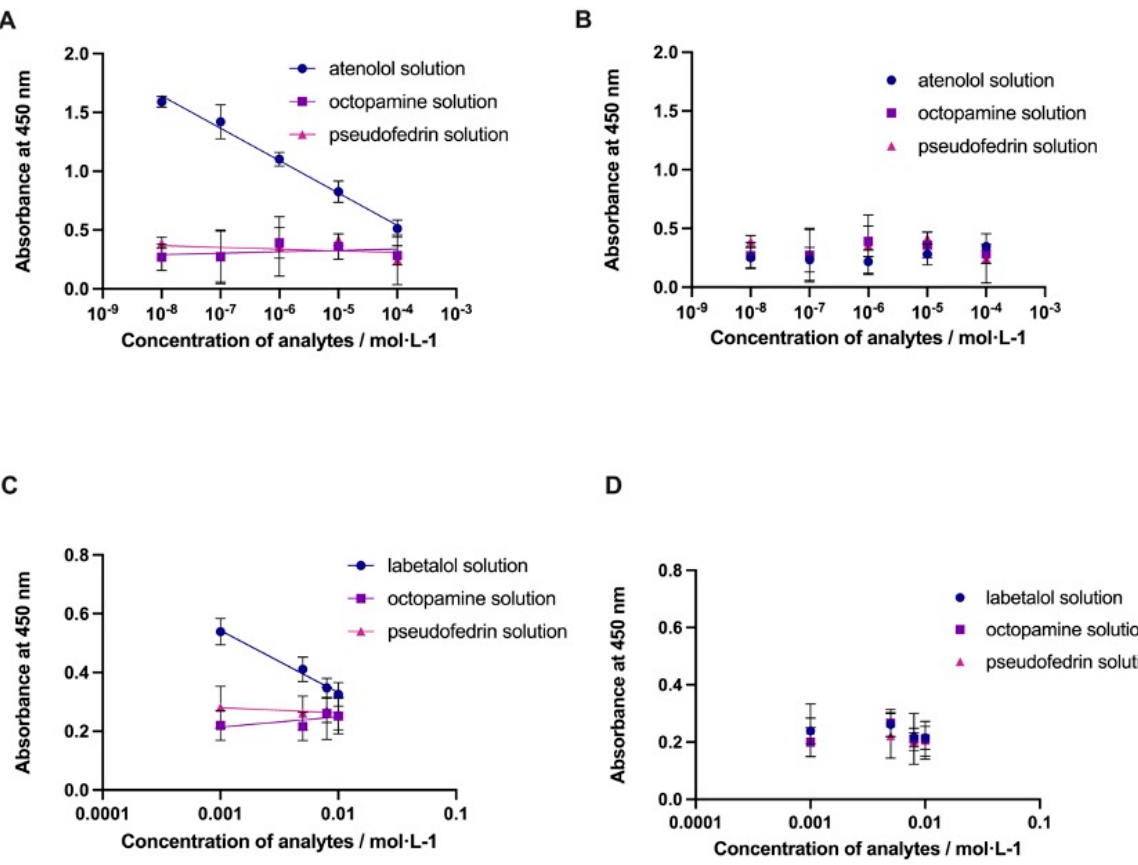
Figure 8. Results of competitive-type pseudo-ELISA assay for nanoMIPs-A ( A ), nanoMIPs-L ( C ), and control performed for nanoMIPs prepared for serotonine ( B , D ). control performed for nanoMIPs prepared for serotonine ( B , D